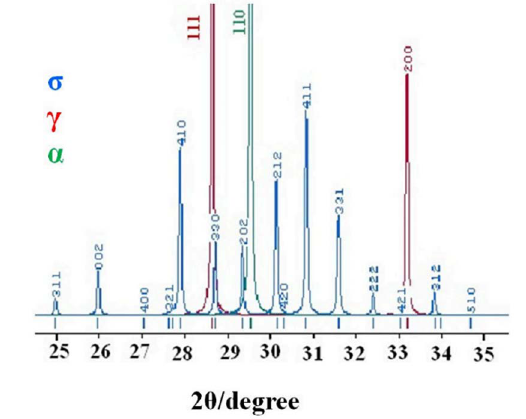
Figure 3. Sigma peaks simulation for austenitic stainless steel.